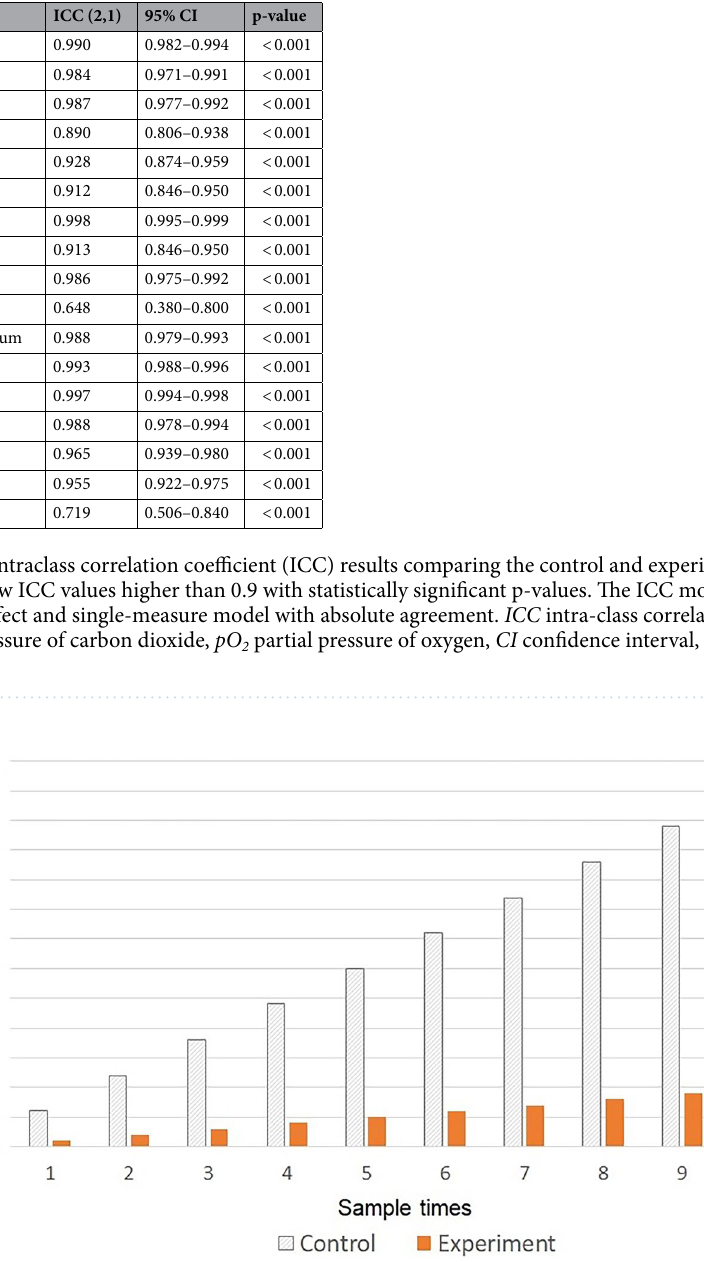
Figure 4. Difference in blood loss between the control and experimental groups. In the control group, 5 mL of dead space volume and 1 mL of sample volume were removed. In the experimental group, only 1 mL of sample volume was retrieved from the participant. (n = 50 for each